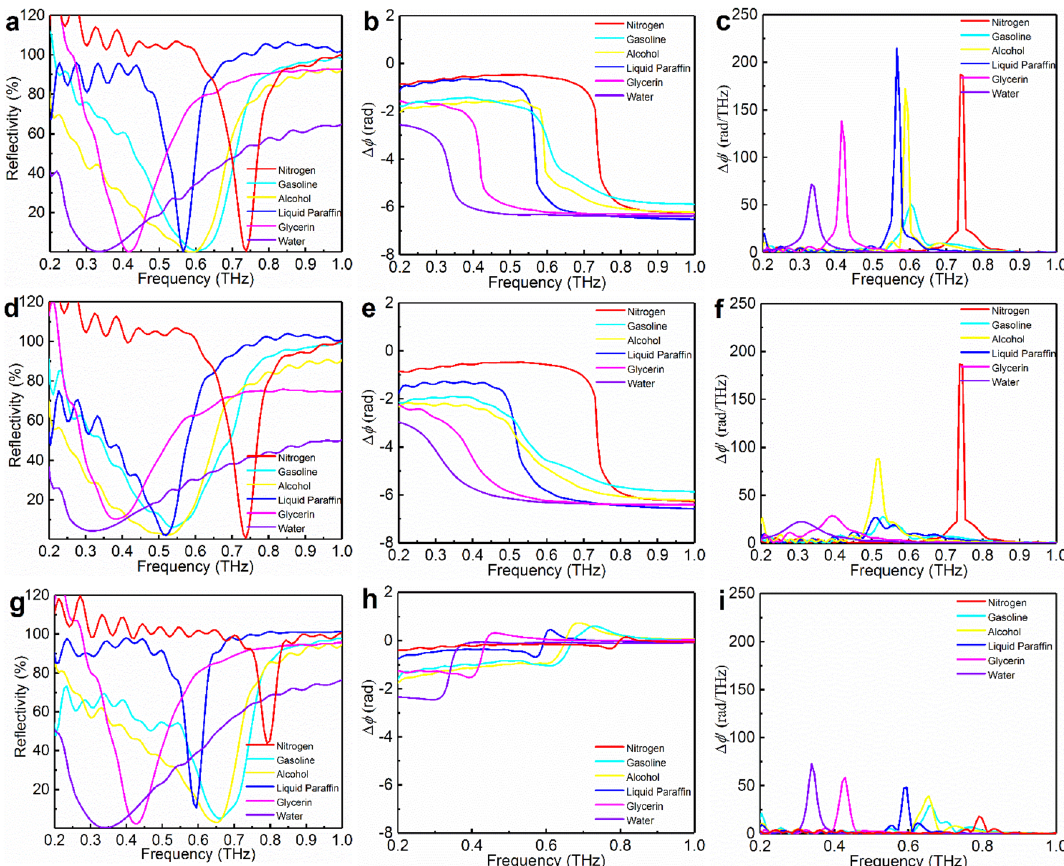
Figure 7: Experimental results for liquids sensing with three coupling gaps controlled methods. (a) Reflectivity spectra, (b) Δ ϕ spectra, and (c) Δ ϕ ′ spectra for optimal gaps; (d) Re fl ectivity spectra, (e) Δ ϕ spectra, and (f) Δ ϕ ′ spectra for g = 40 μ m; (g) Re fl ectivity spectra, (h) Δ ϕ spectra, and (i) Δ ϕ ′ spectra for g = 65 μ